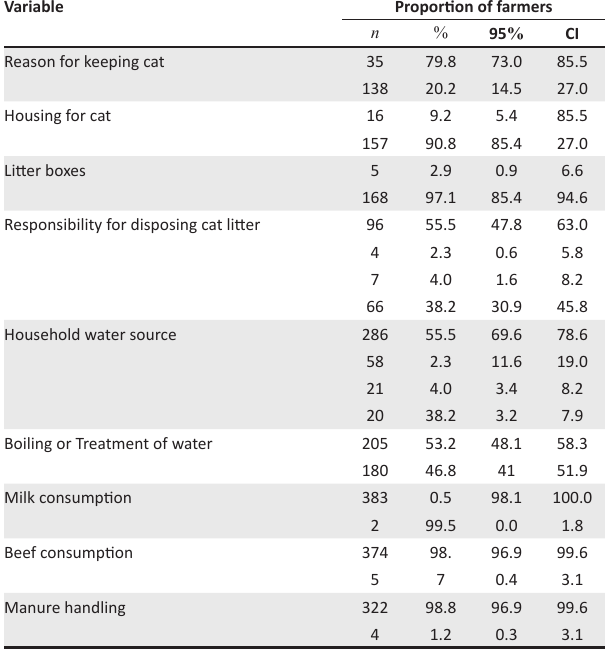
TABLE 2: Potential risk factors for